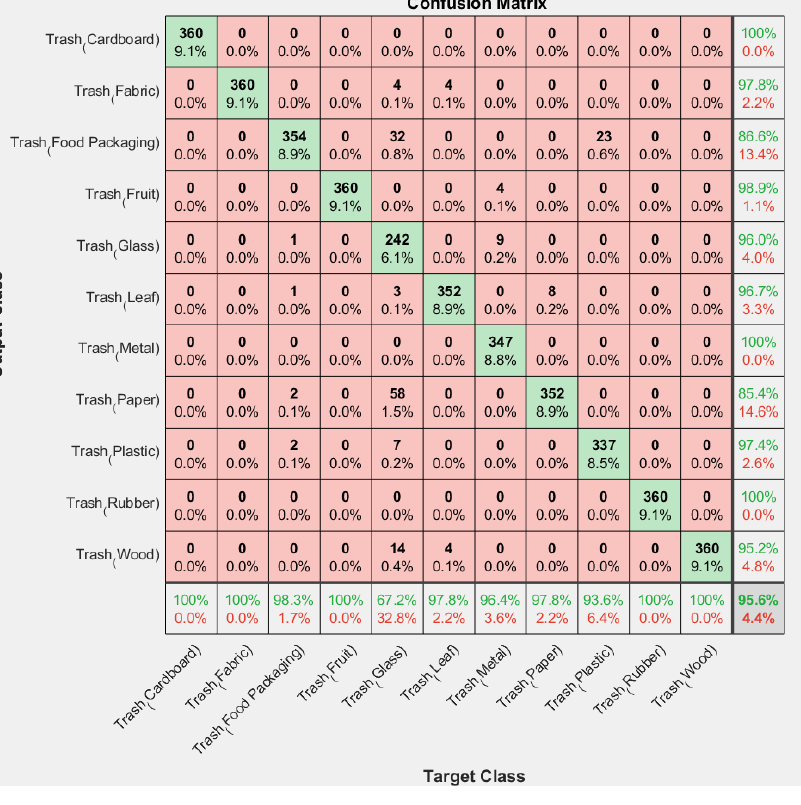
Figure 17. Result of confusion matrix trash using VGG16.